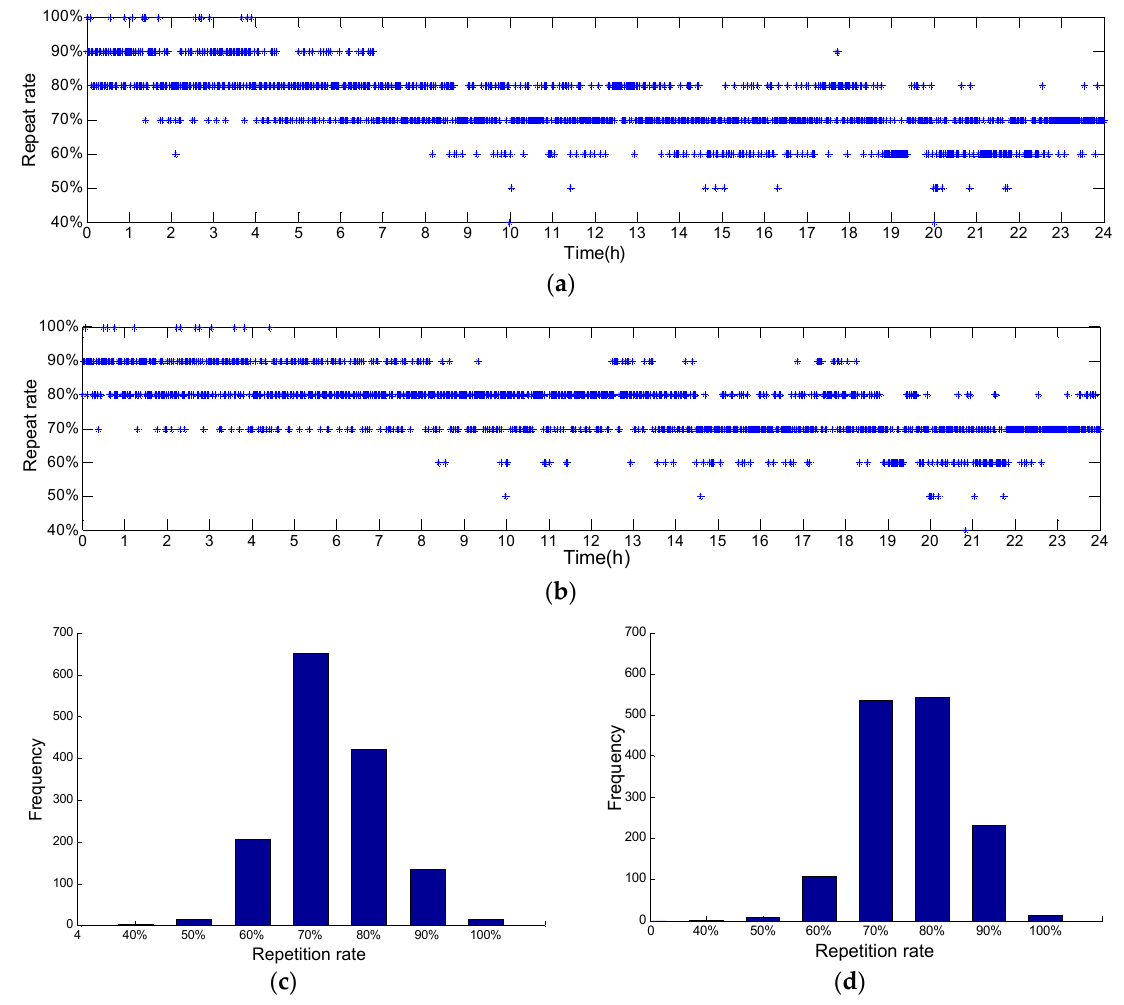
Figure 20. The changes of the MAC repetition rate in a day: ( a ) the datum is at the beginning of 0:00 am; ( b ) the datum is at the beginning of 12:00 am; ( c ) the histogram of the MAC repetition rate of ( a ); ( d ) the histogram of the MAC repetition rate of ( b ).